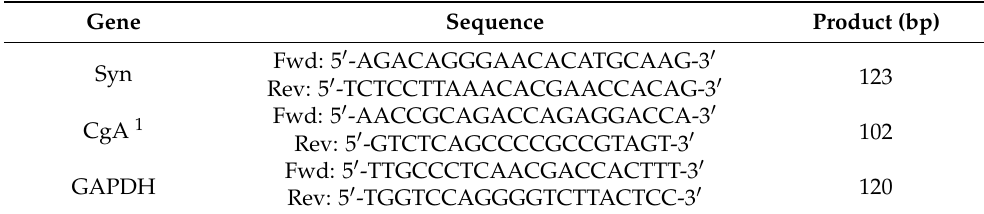
Table 2. Primers used to identify neuroendocrine